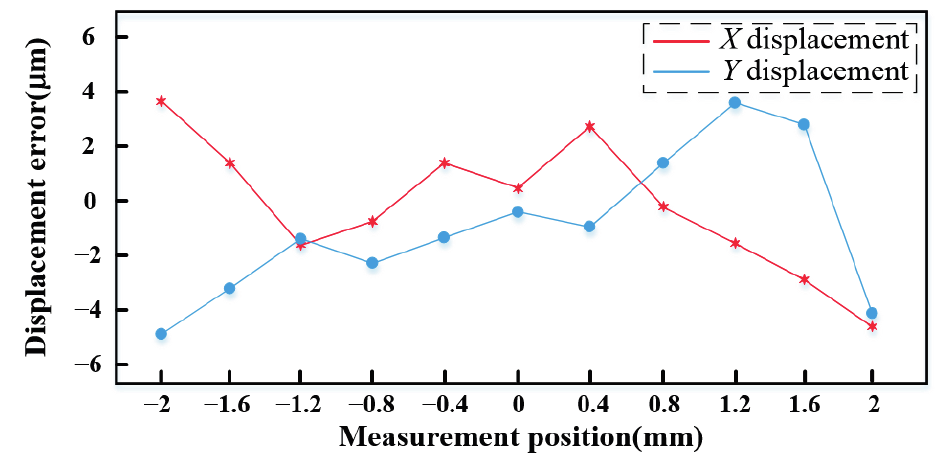
Figure 18. Measurement error of XY displacements.